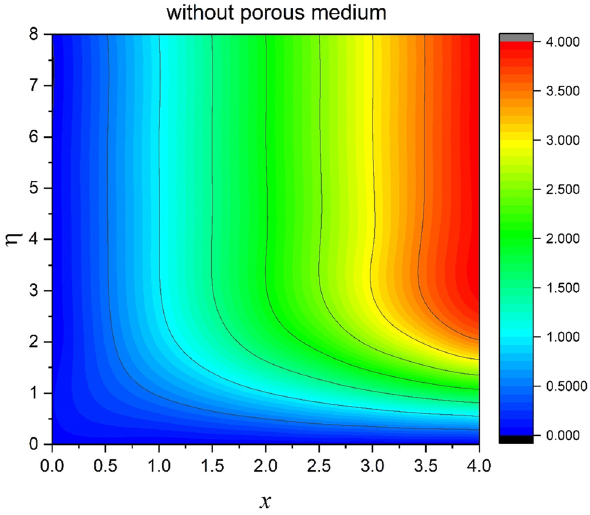
Figure 15: Streamline pattern when porous medium is absent.